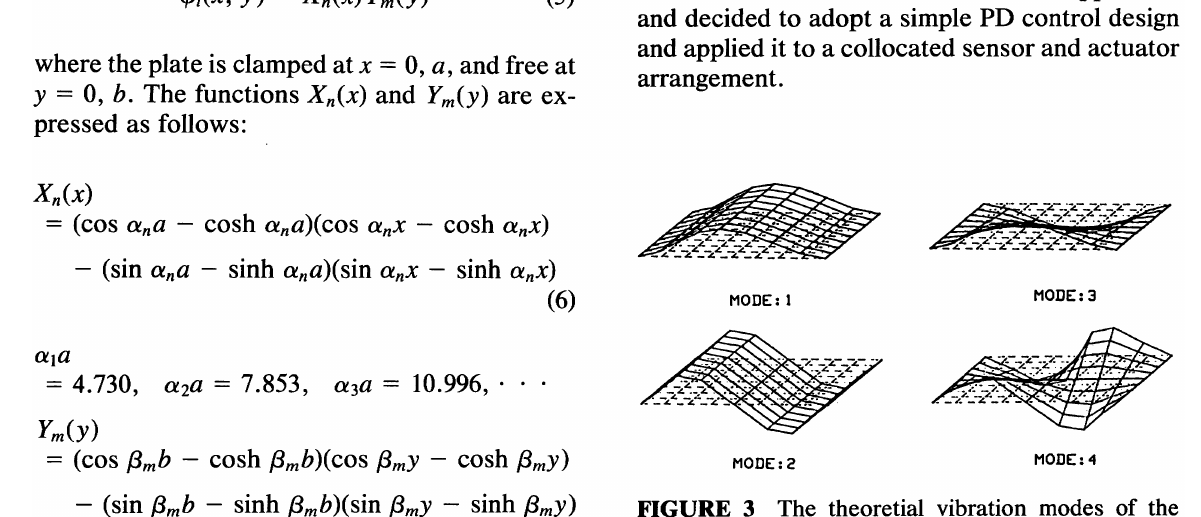
FIGURE 3 The theoretial vibration modes of the